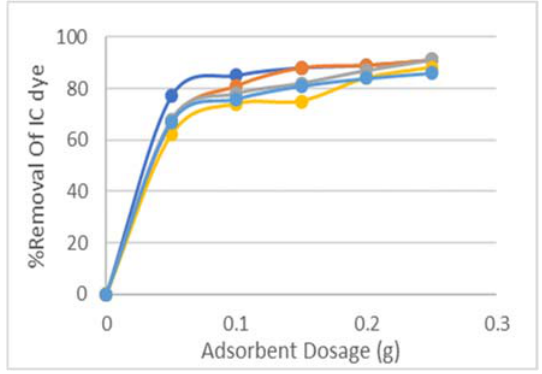
Fig. 7. The effects of dosage on the removal efficiency at 30 o C , 4 days contact time.